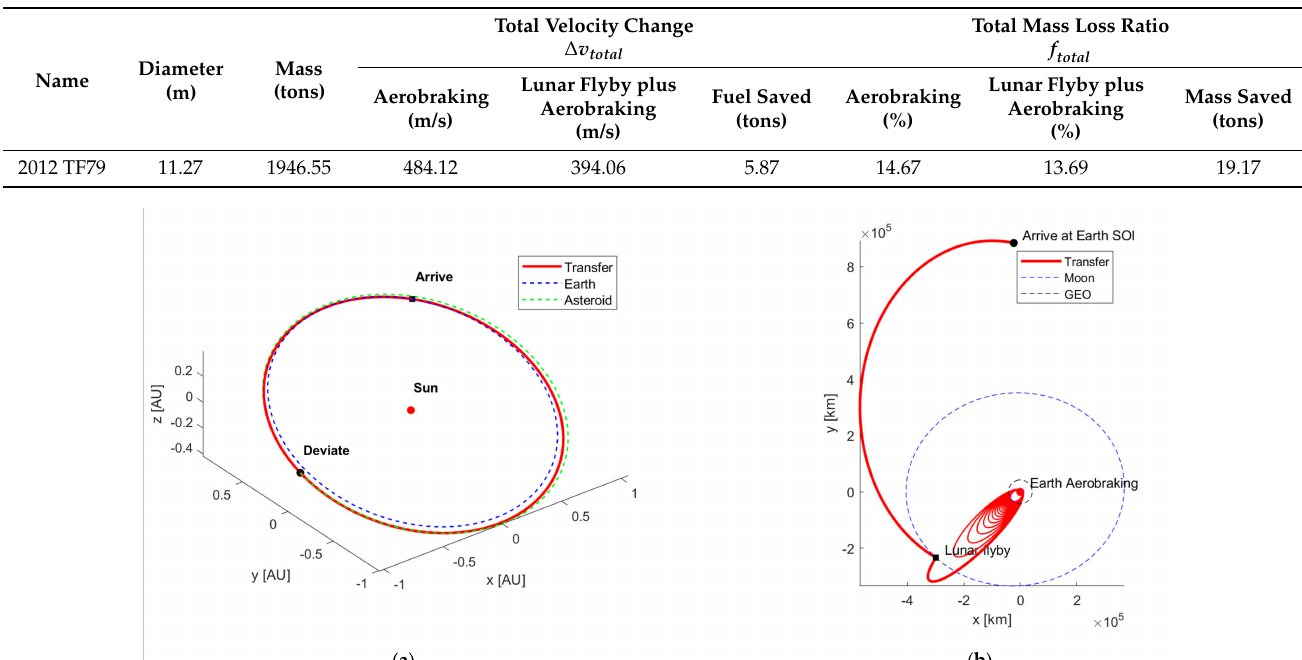
Table 7. Comparison details of total velocity change and total mass loss ratio.